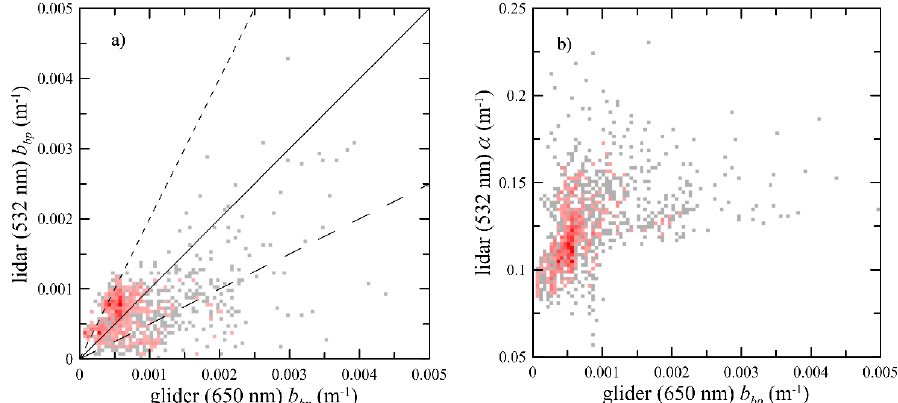
Figure 4. ( a ) Scatter plot of binned particulate backscatter coefficient b bp as measured by lidar at 532 nm (unpolarized) as a function of those inferred from the glider data at 650 nm for the north transect. Grey squares denote a single data point within the region covered by the square (5 × 10 − 5 m − 1 in each dimension). Red squares denote multiple data points from two (lightest) to 20 (darkest shade) of 1228 total. Lidar data are from the 10 July flight. Solid line is the ideal 1:1 relationship for χ (180°) = 1. Short dashes show the 1:1 line, relative to the data, for χ (180°) = 0.5, and long dashes for χ (180°) = 2.0; ( b ) Similar plot of lidar attenuation, α , with darkest red representing 11 data points.